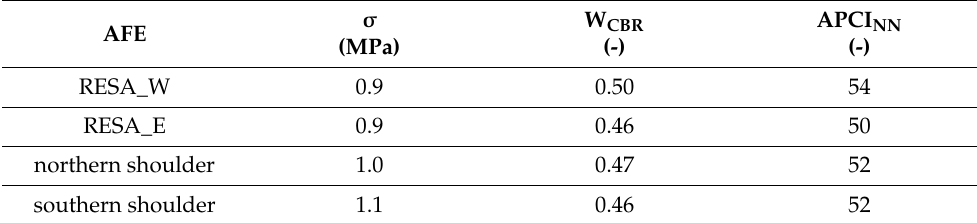
Table 9. Results of the assessment of the technical condition of natural airfield pavements.